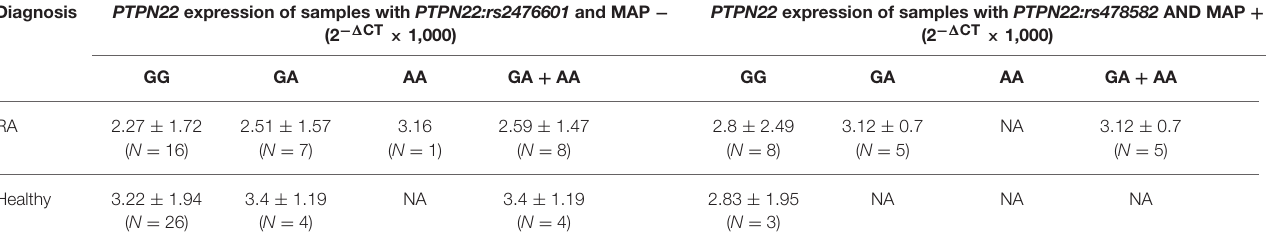
TABLE 5 | Effect of combined PTPN22:rs2476601 and MAP presence on PTPN22 expression.